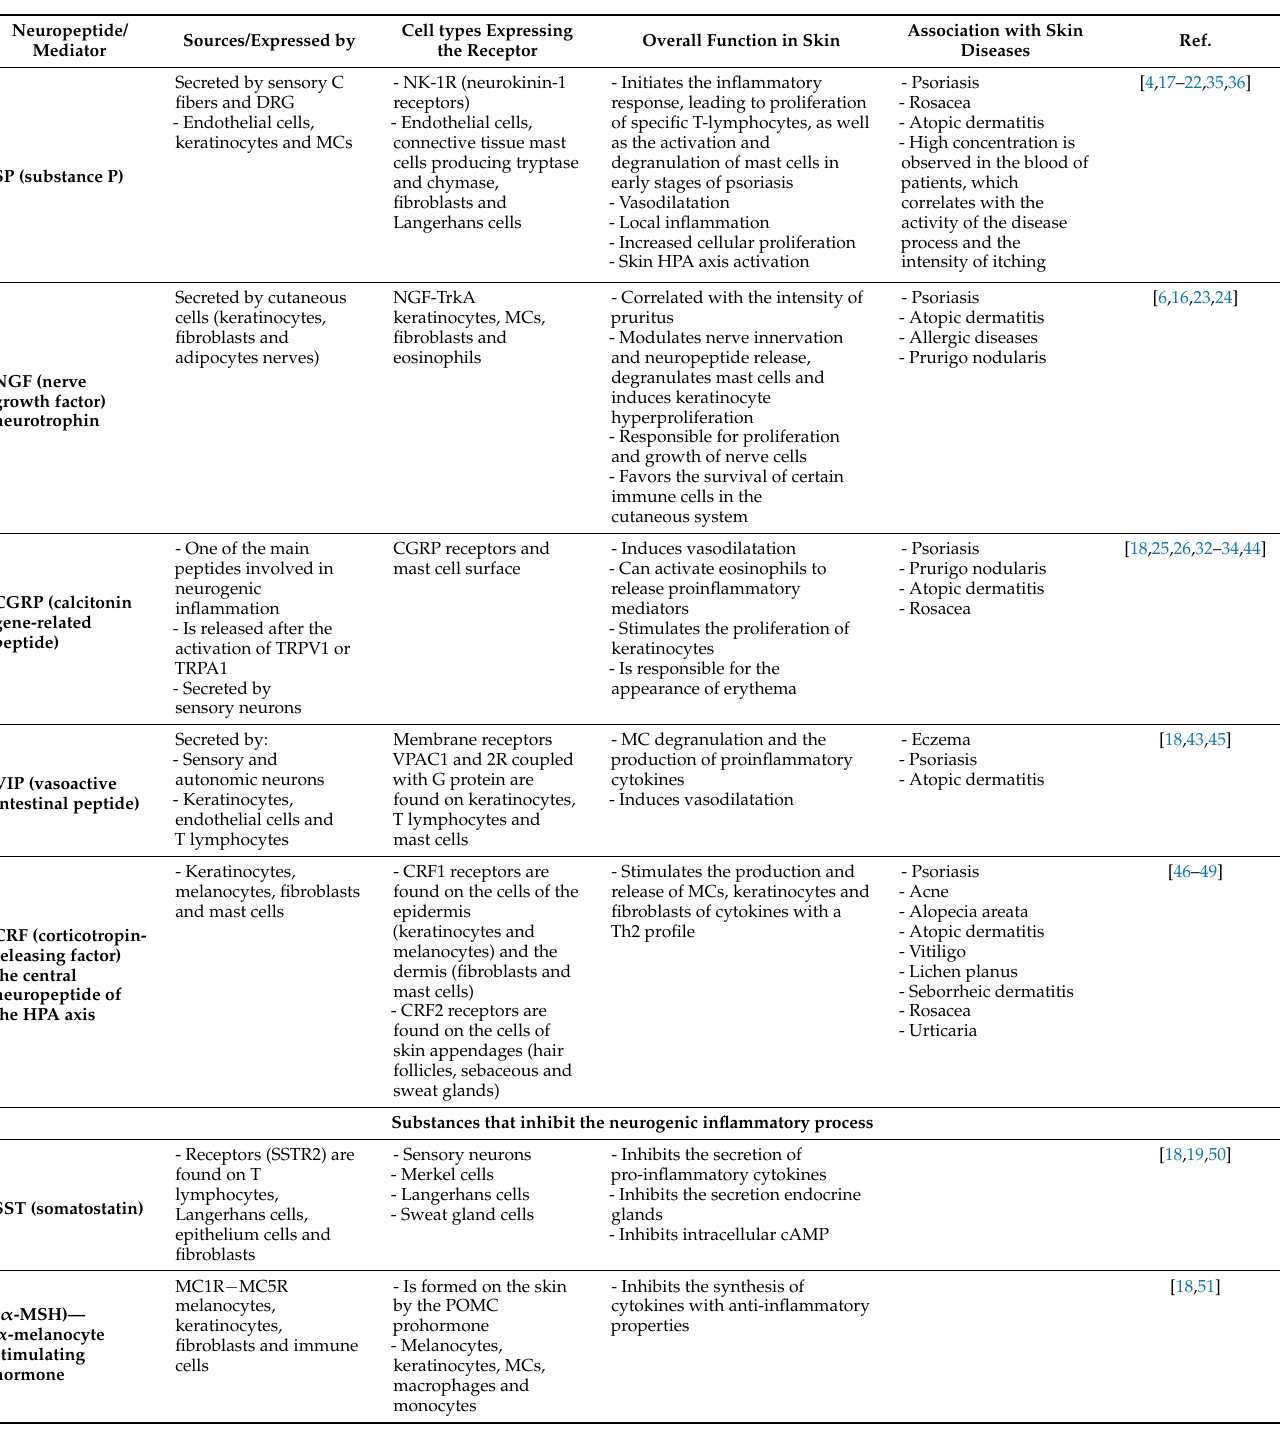
Table 1. Selected neuropeptides/mediators and their roles in